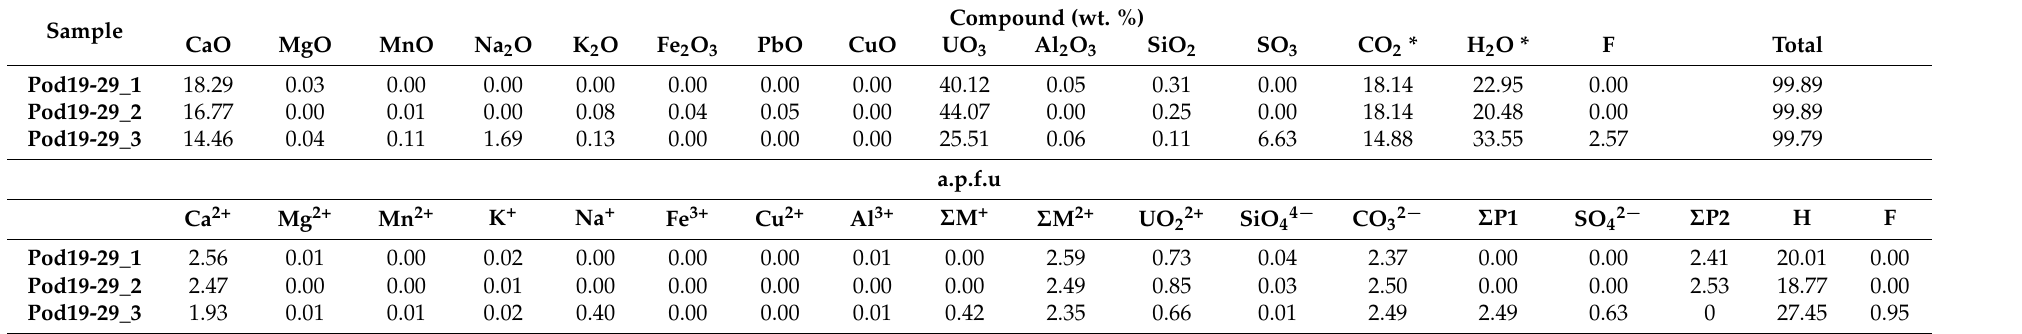
Table 7. Chemical composition of uranyl carbonates from Podg ó rze mine (EPMA).